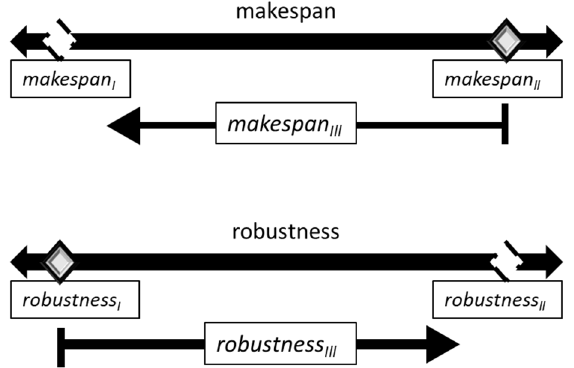
Figure 2. Graphical representation of the three-stage procedure in terms of makespan and robust-